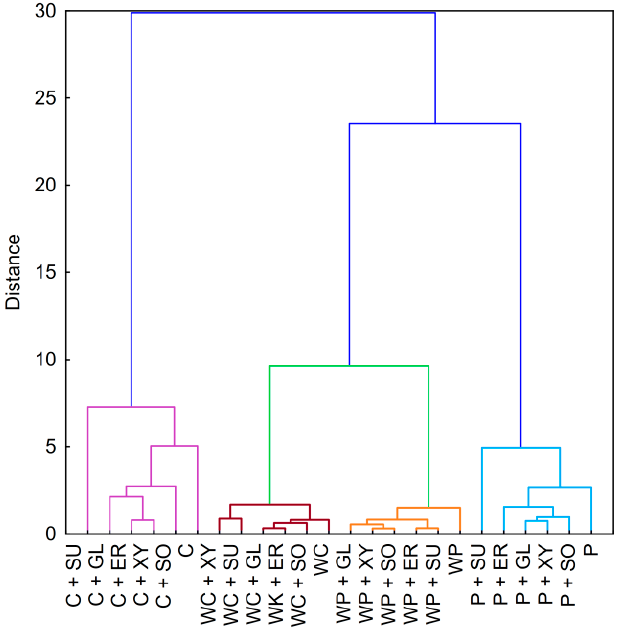
Figure 6. Dendrogram of hierarchical cluster analysis of binary mixtures of 5% native starch pastes with 10% sweetening agents. Explanatory notes: P—potato starch; WP—waxy potato starch; C—corn